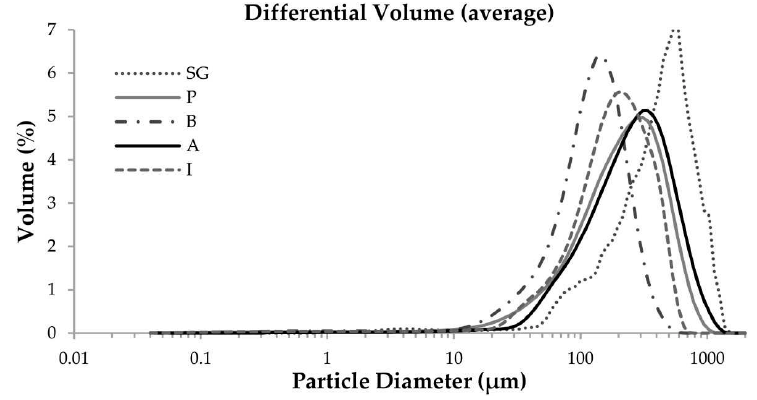
Graph 2. Granulometric curve (volume %) of different PU